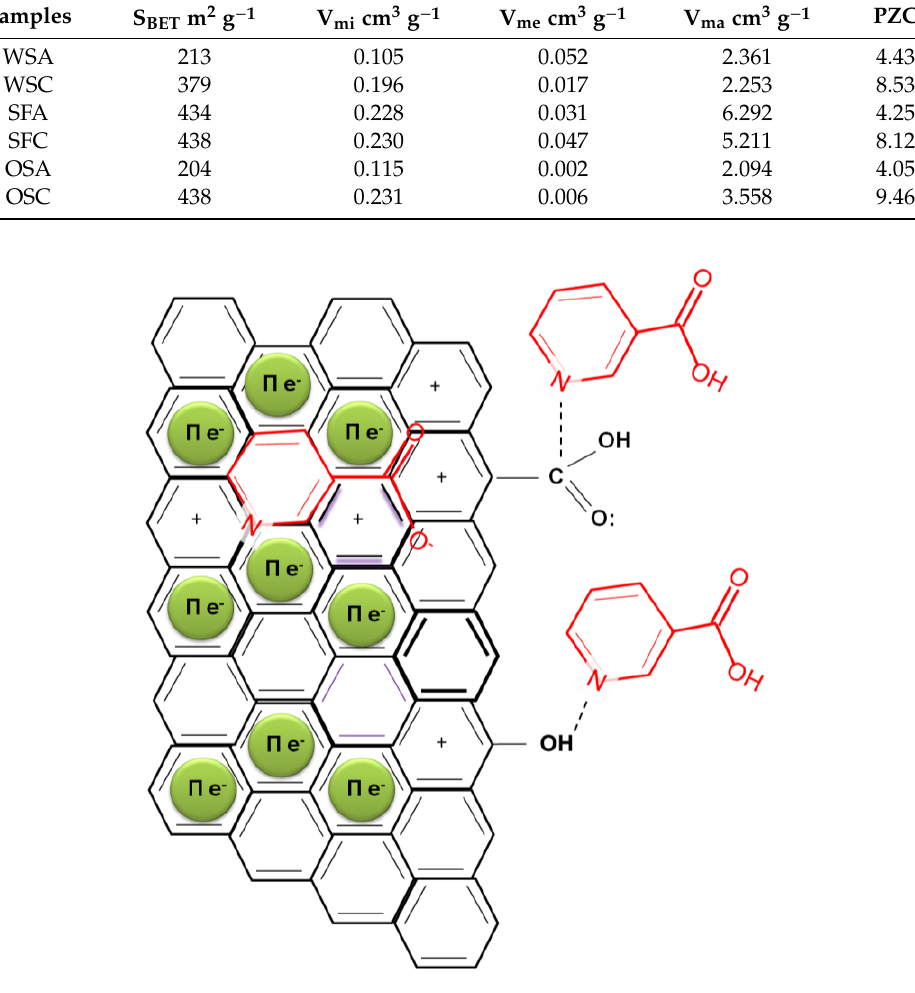
Figure 4. Mechanisms of adsorption of nicotinic acid onto activated hydrochars.